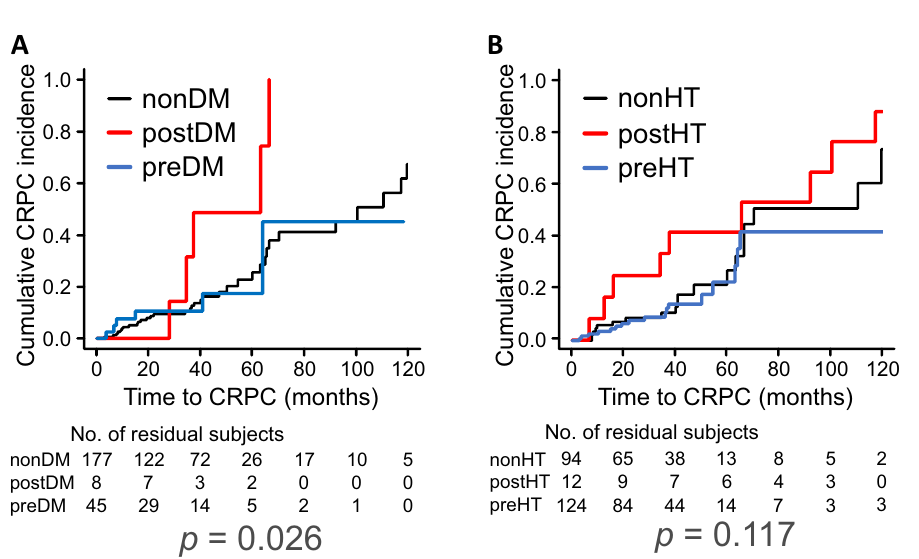
Figure 1. Impact of DM and HT on the time to CRPC progression in PC patients undergoing hormone therapy. DM and HT were separated into preexisting ones (preDM and preHT) and newly developed ones (postDM and postHT). Kaplan–Meier curves show the time-related progression to CRPC in patients who had preDM, postDM and no DM (nonDM) ( A ) and who had preHT, postHT and no HT (nonHT) ( B ). Statistical differences among groups were analyzed by the log-rank test. p values are shown in the bottom of each